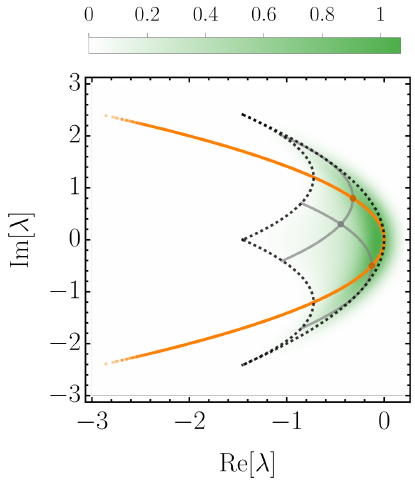
Figure 2 . Spectral loci of BNGL for the SYK model. Eigenvalue density distribution on the complex plane (from white to green) of the BNGL, κ = 2 Liouvillian (5.17) and distinct eigenvalues (orange) of the ED Liouvillian (5.21). In both models the dephasing strength is taken as γ = 1 . The eigenvalues of the undeformed SYK Hamiltonian H 0 for 2 N = 26 Majorana Fermions were calculated with exact diagonalization. The spectral density of the BNGL, κ = 2 Liouvilian can be approximated by the product of two identical Q-Hermite forms, deformed to parabolas (gray solid lines), centered on the spectral locus of the ED model. The theoretical boundary (dashed grey line) is given by eq.